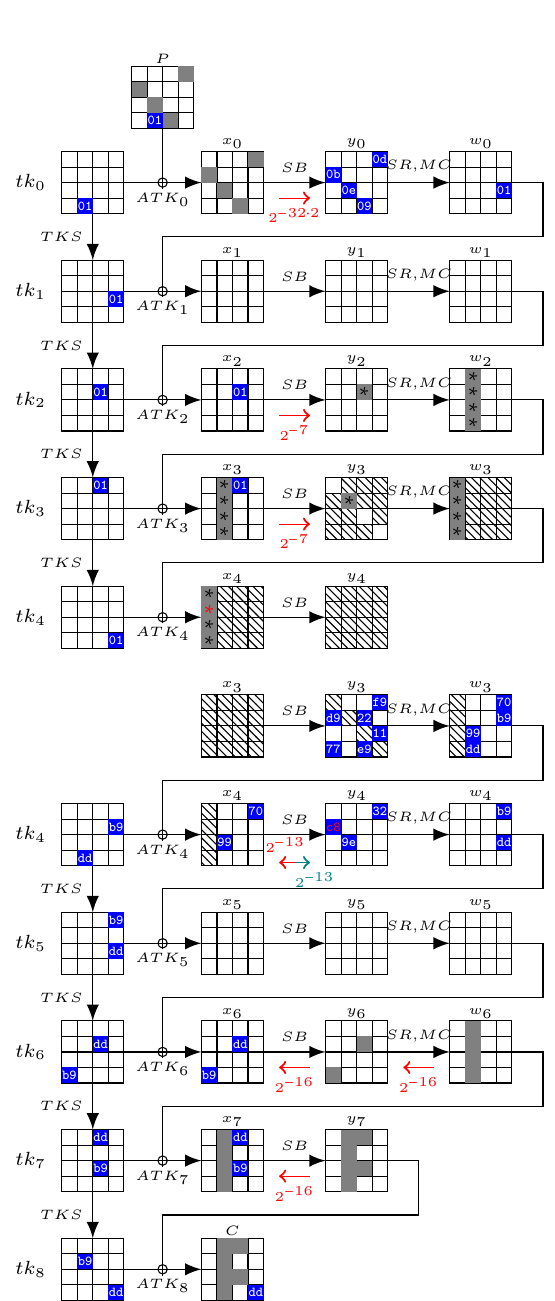
Figure 14: Truncated boomerang attack on 8-round Deoxys-BC in the RTK1 model, which is taken from Fig. 7. Truncated boomerang attack on 8-round Deoxys-BC in the RTK1 model, start- ing from the ciphertext side. This attack succeeds with probability 1 / 2.